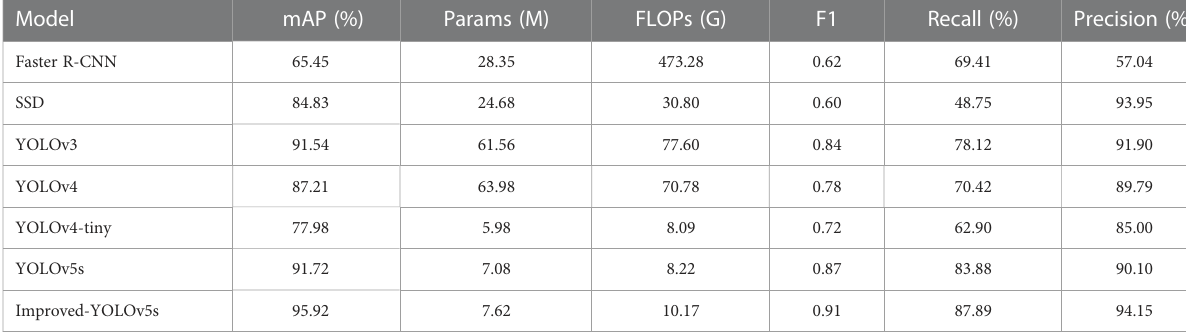
TABLE 4 Comprehensive performance comparison.